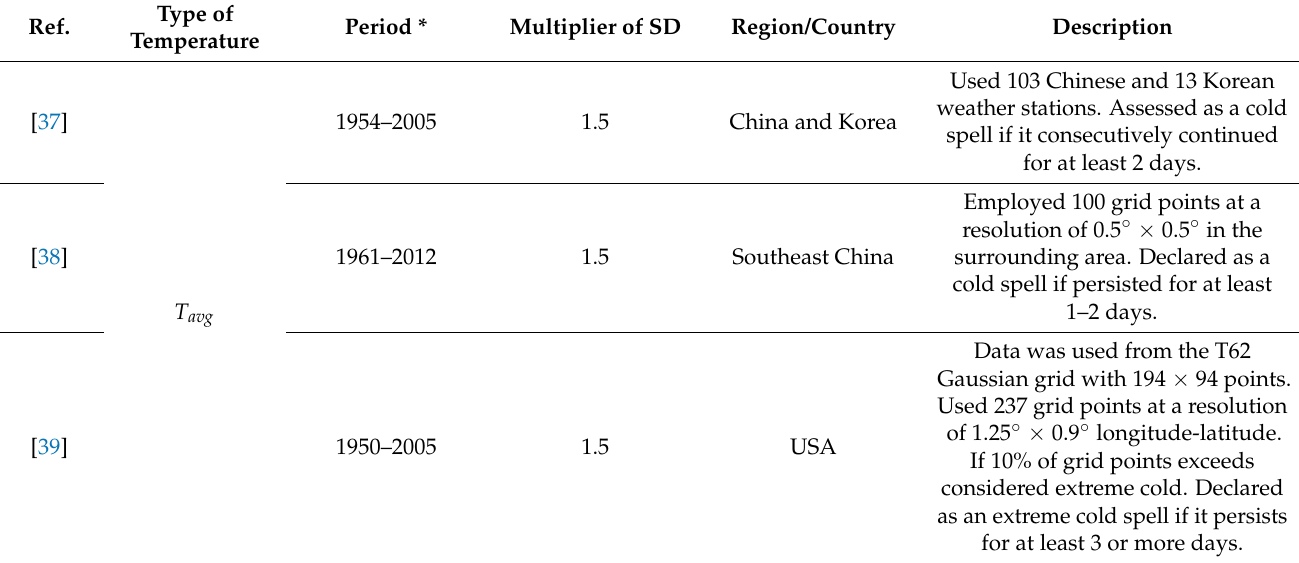
Table 1. Some example case studies that used the temperature anomalies